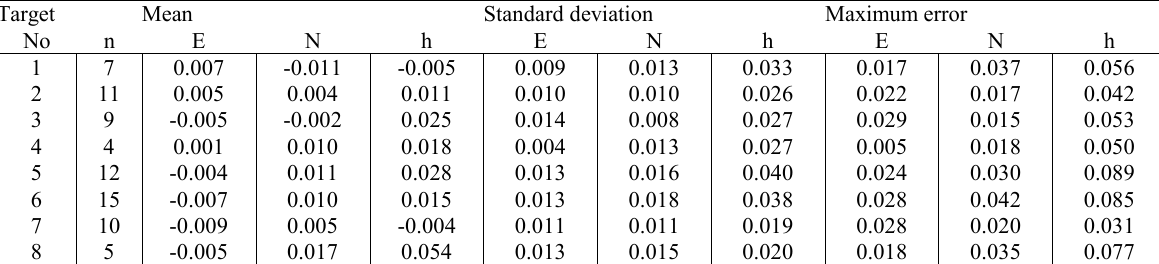
Table 3. Internal deviation of the target sphere locations computed from Akhka MLS passes, units in mm, n shows the number